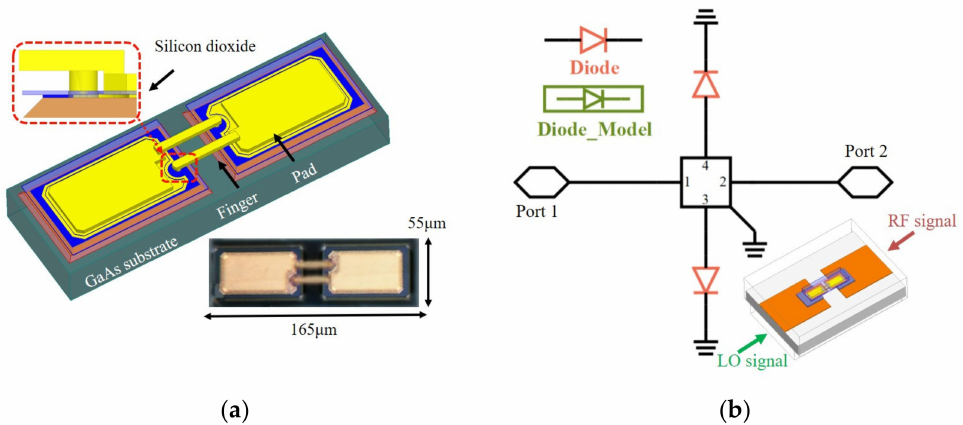
Figure 3. The schematic diagram of an anti-parallel Schottky diode. ( a ) The 3D electromagnetic (EM) model of the diode and its photograph; ( b ) A SPICE model of the anti-parallel Schottky